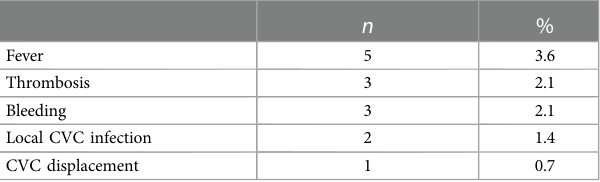
TABLE 4 Central venous catheter (CVC) related adverse events.